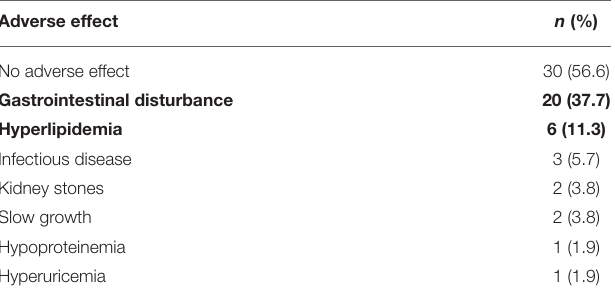
TABLE 6 | Adverse effects reported during the KD treatment. Adverse